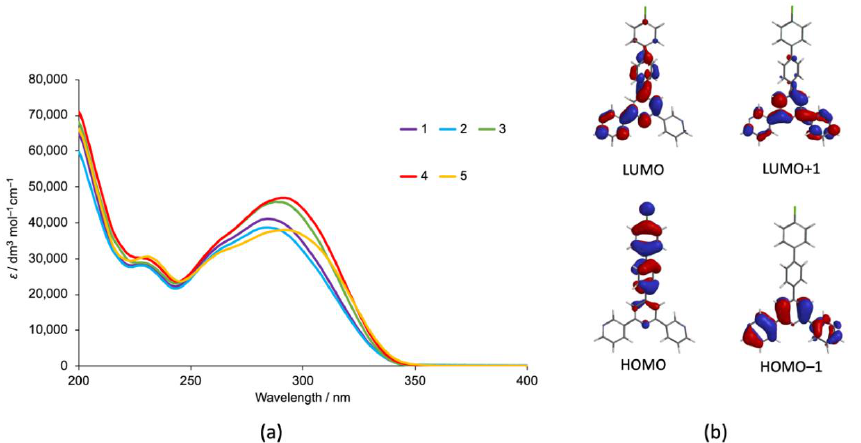
Figure 2. ( a ) Solution absorption spectra (MeCN, 2.0 × 10 − 5 mol dm − 3 ) of compounds 1 – 5 . ( b ) Highest occupied and lowest unoccupied molecular orbital compositions in compound 3 ; similar compositions are seen in 2 and 4 .